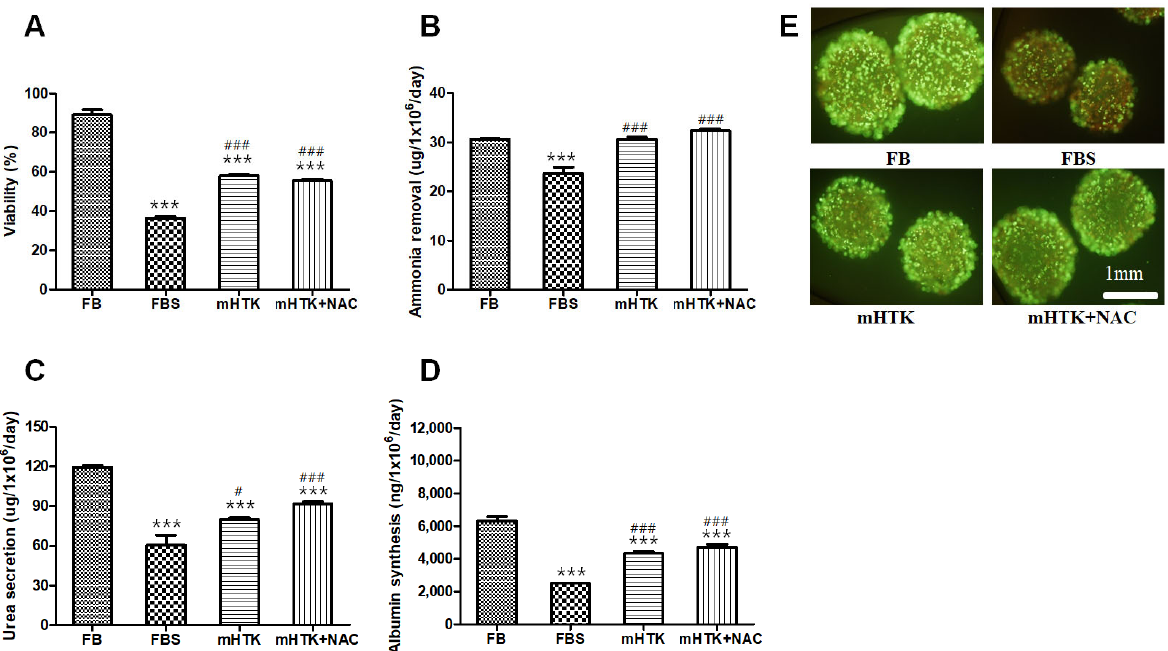
Figure 4. Effect of cryopreservation solutions on porcine hepatocyte spheroid beads’ viability and liver-specific functions in post-thaw cultures. Porcine hepatocyte spheroid beads were cryopreserved in three different freezing solutions containing 15% DMSO and stored for 1 year in liquid nitrogen. Porcine hepatocyte spheroid beads were warmed rapidly in a water bath and washed twice in thawing medium (first, hepatocyte spheroid beads were suspended in a warm medium with 10% FBS rapidly, and then the medium was replaced with a warm HDM). ( A ) Cell viability, ( B ) ammonia removal, ( C ) urea secretion, and ( D ) albumin synthesis were evaluated after thawing and plating for 24 h. Representative images of ( E ) porcine hepatocyte spheroid beads showing their vital staining after thawing and maintenance in culture for 24 h. Live/Dead TM cell viability assay showing live cells stained with Calcein-AM (green) and dead cells stained with EthD-1 (red). Fresh hepatocyte spheroid beads (upper left, FB) and hepatocyte spheroid beads cryopreserved using fetal bovine serum + DMSO (upper right, FBS), modified HTK + DMSO (lower left, mHTK), and modified HTK + N-acetylcysteine + DMSO (lower right, mHTK + NAC). Statistical significance compared to fresh primary hepatocyte spheroid beads (FB): *** p < 0.001 and compared to the control freezing solution (FBS): # p < 0.05, ### p <